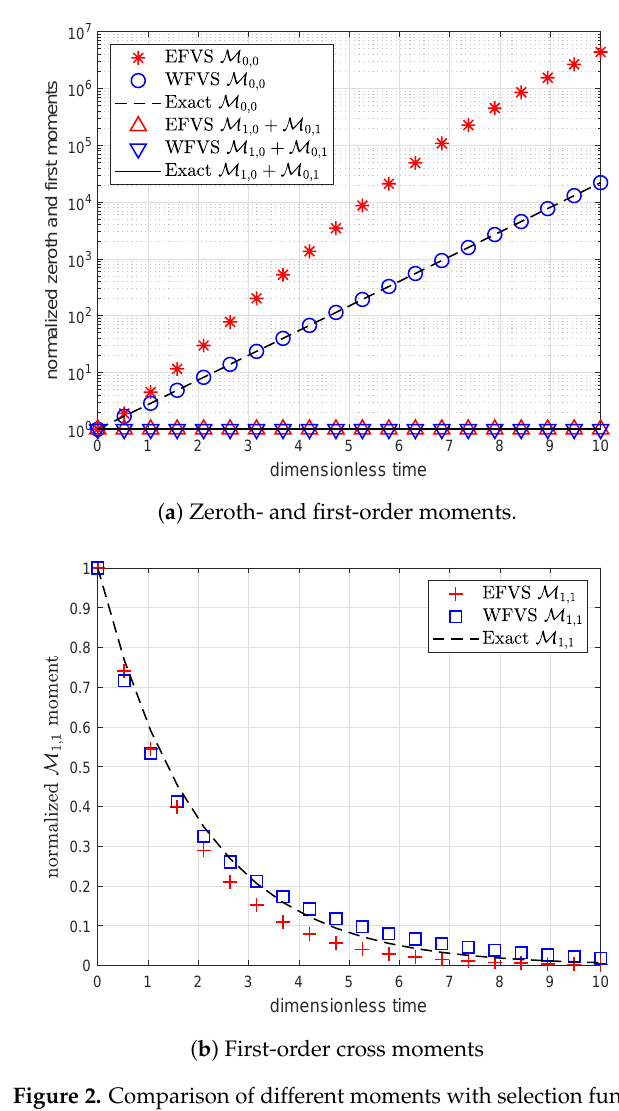
Figure 2. Comparison of different moments with selection function S = 1, and breakage function b 2